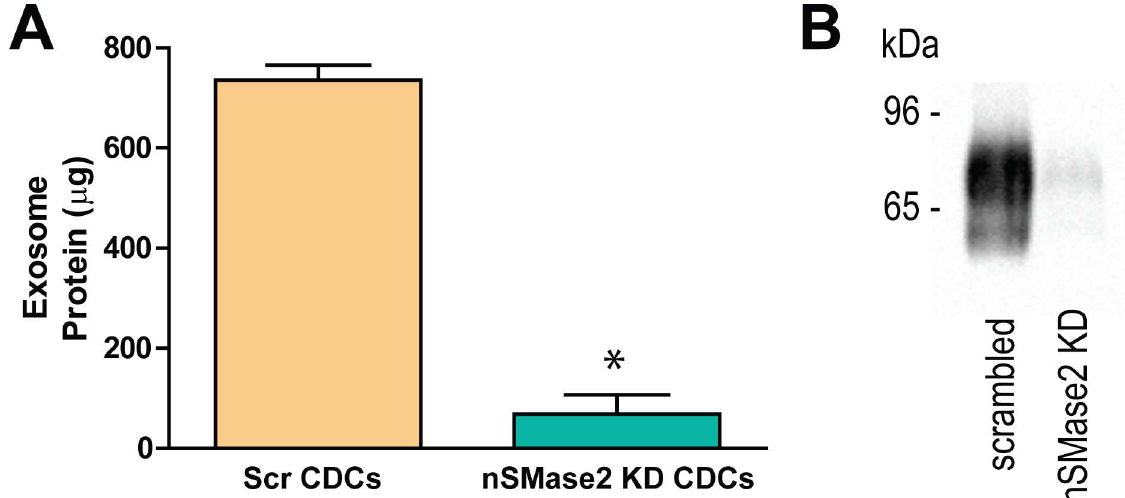
Fig 4. Stable transduced hCDC-nSMase2 lentiviral knockdown lines block exosome secretion. (A) Bradford assay and (B) immunoblot analysisof CD63 of exosomes from CDCs transduced with lentiviral vectors for scrambled or nSMase2-specific shRNAi show nSMase2 knockdown results in significantly less releaseof exosomes from human CDCs (n = 3). * p < 0.01 using two-tailedStudent’s t test. Data are presented as mean ± SEM.